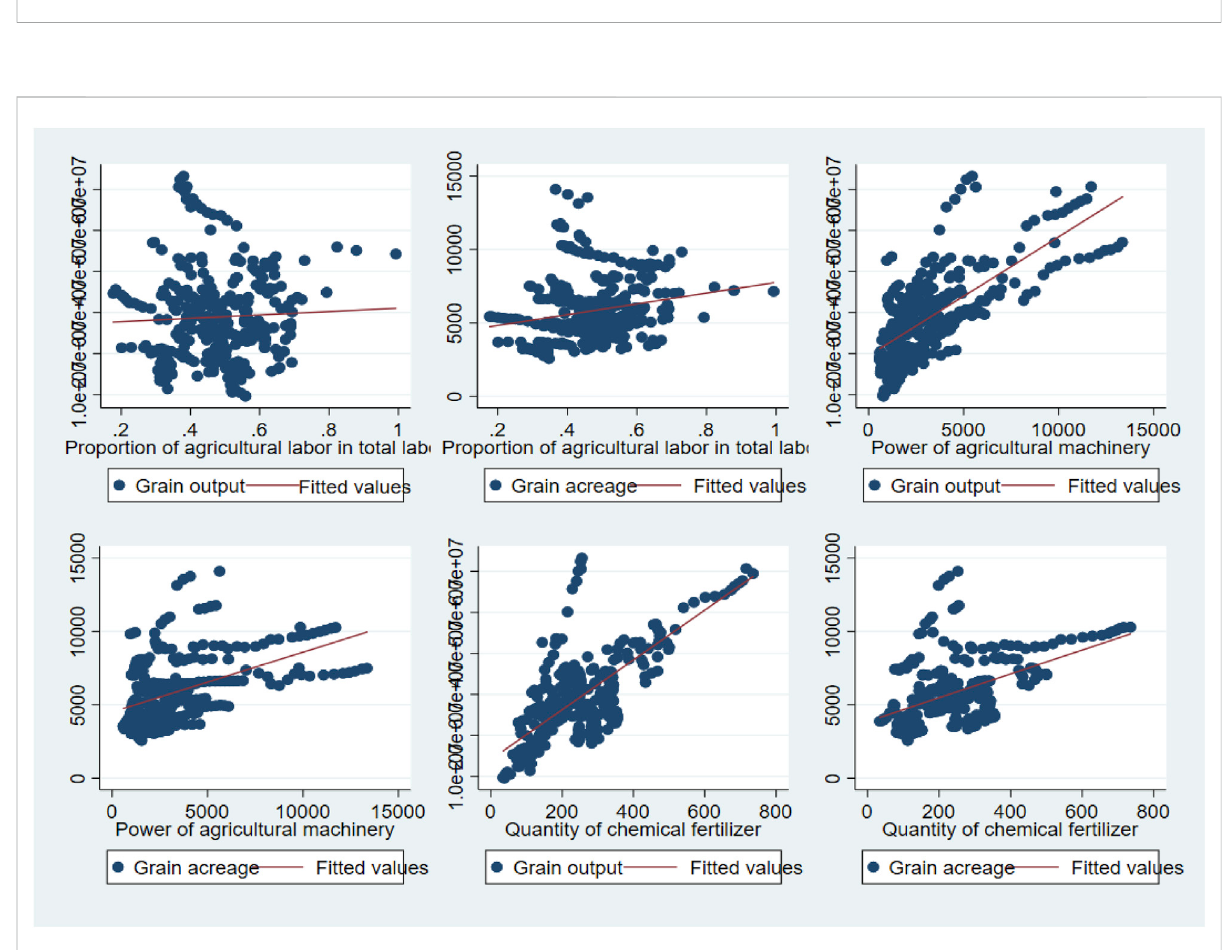
FIGURE 2 Change trend in ALT, grain yield and grain-sown area in China (1990 –